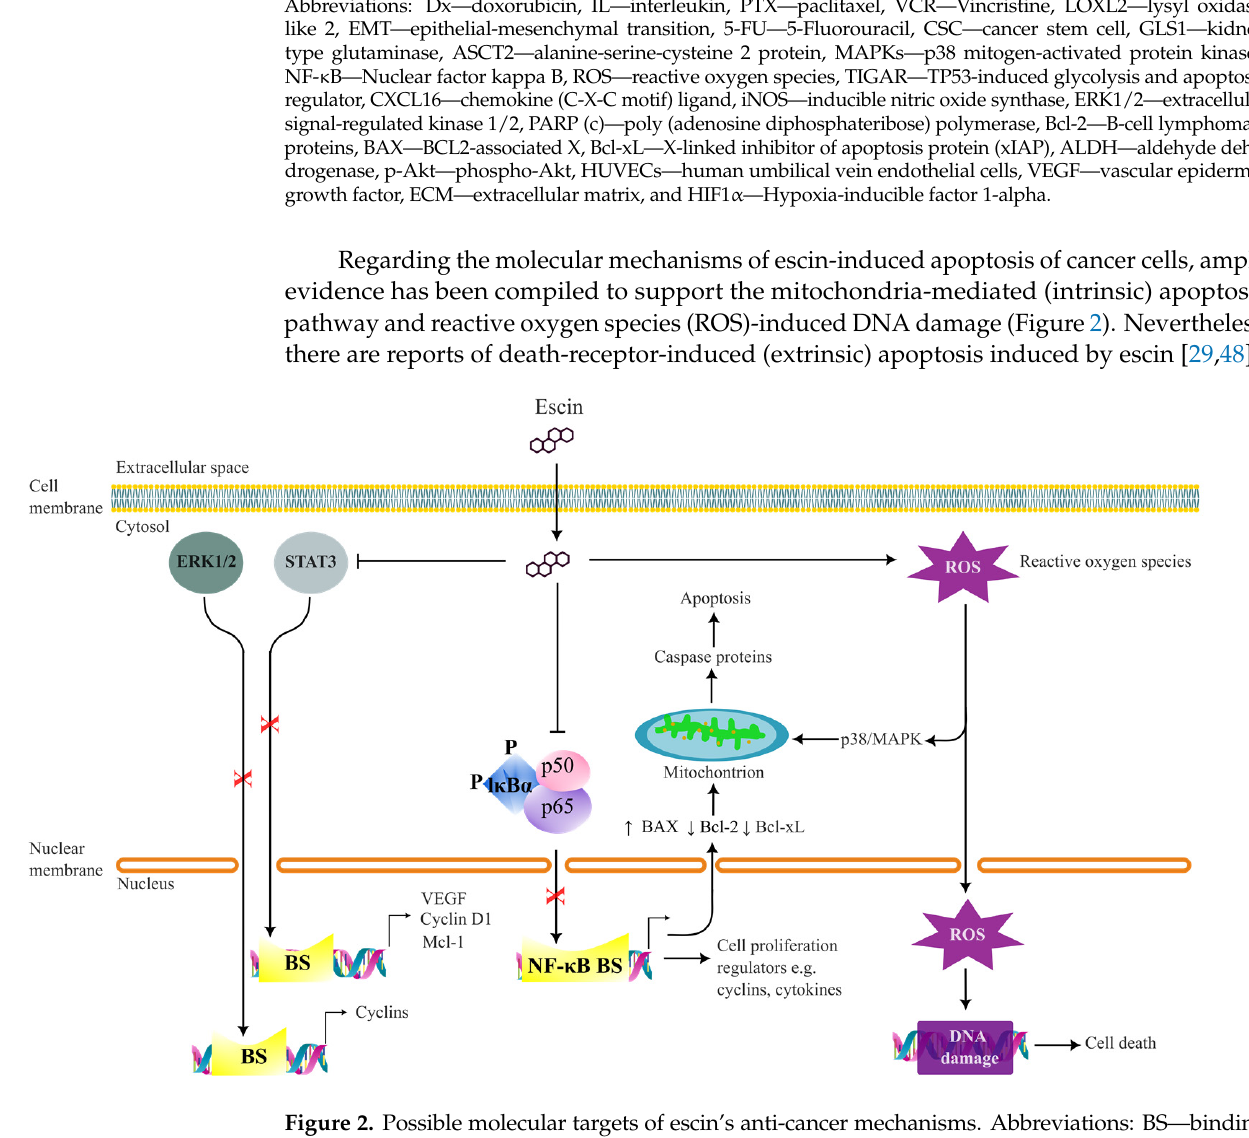
Figure 2. Possible molecular targets of escin’s anti-cancer mechanisms. Abbreviations: BS—binding site, NF- κ B—Nuclear factor kappa B, ERK1/2—extracellular signal-regulated kinase 1/2, Bcl-2—B- cell lymphoma 2 proteins, BAX—BCL2-associated X, Bcl-xL—X-linked inhibitor of apoptosis pro- tein (xIAP), VEGF—vascular epidermal growth factor, MAPKs—p38 mitogen-activated protein ki- nases, I κ B α —cytoplasmic inhibitory protein of NF- κ B,STAT3—signal transducer and activator of transcription protein 3.